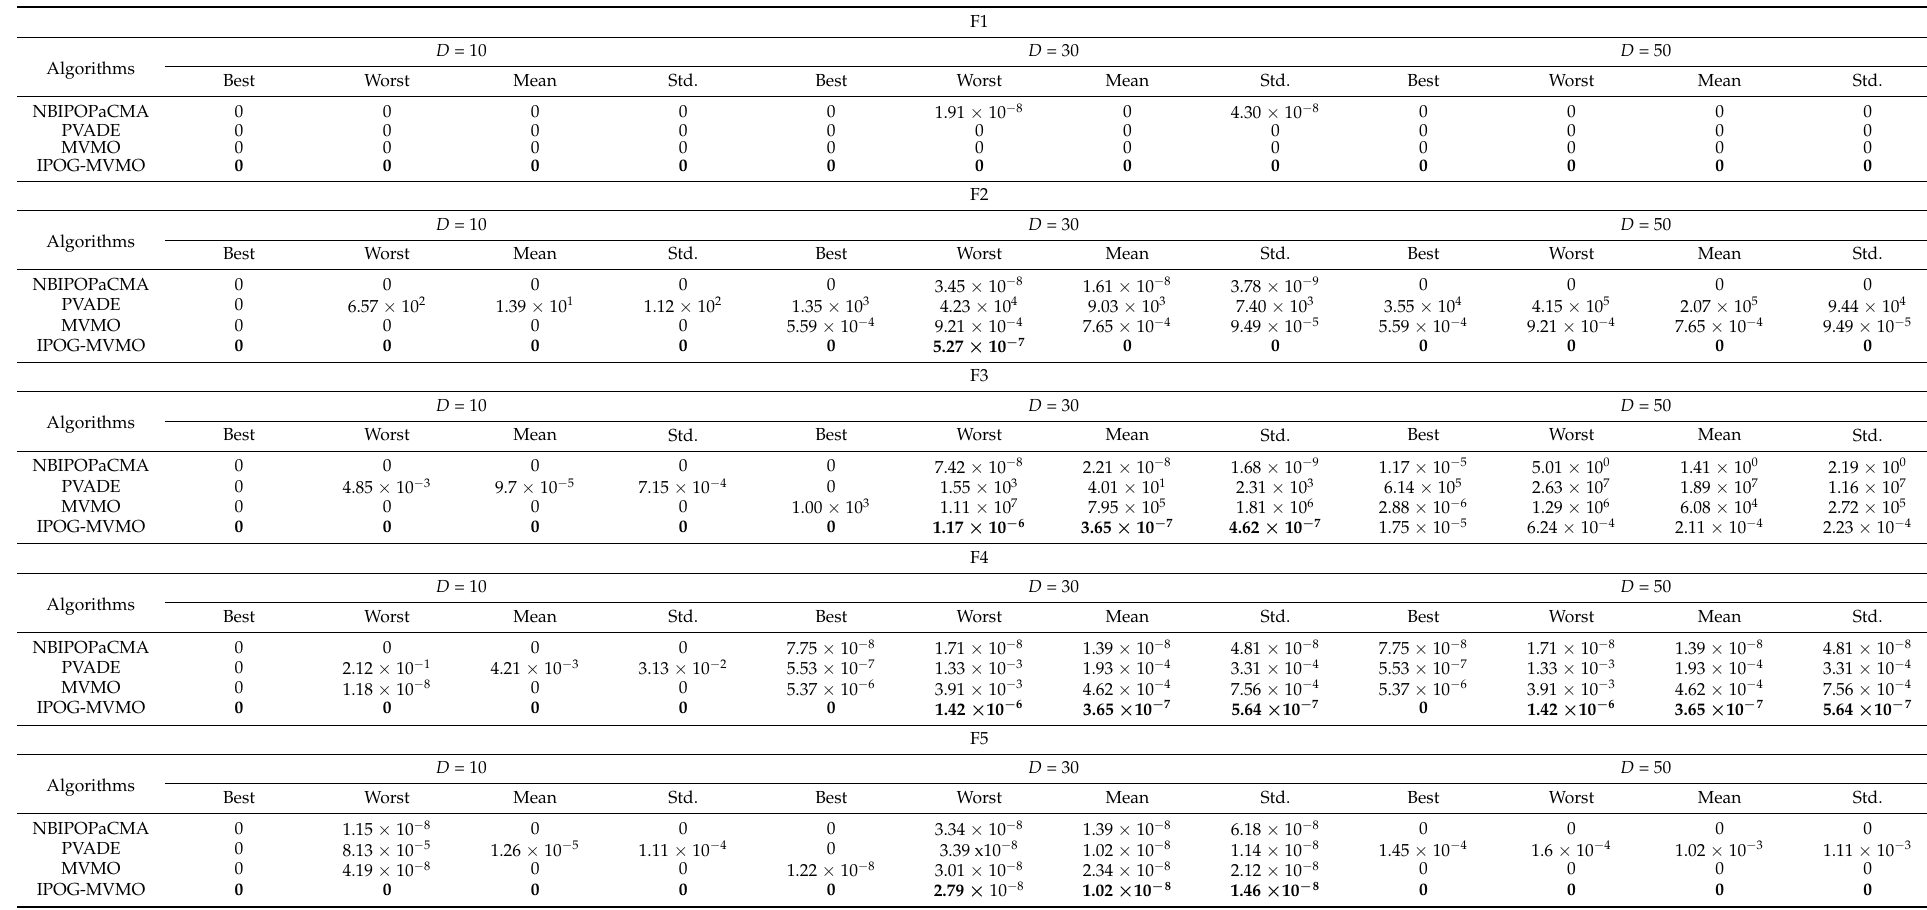
Table 2. The comparative results of the errors obtained from unimodal functions